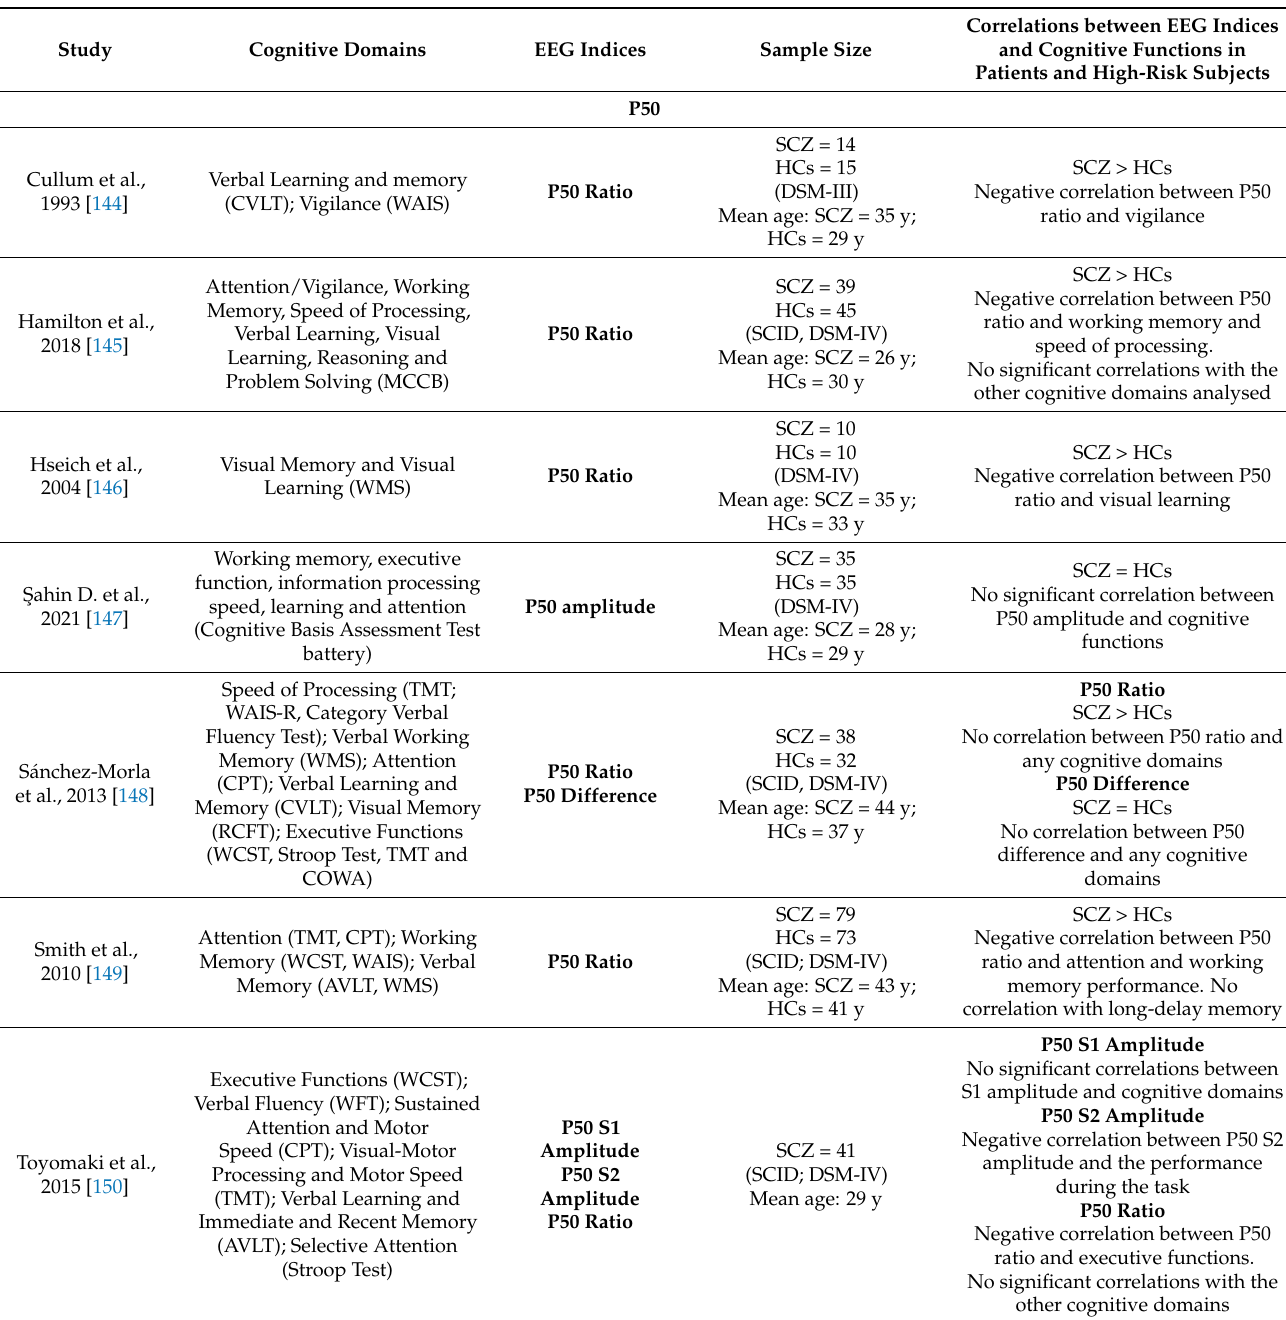
Table 3. Event-related potential